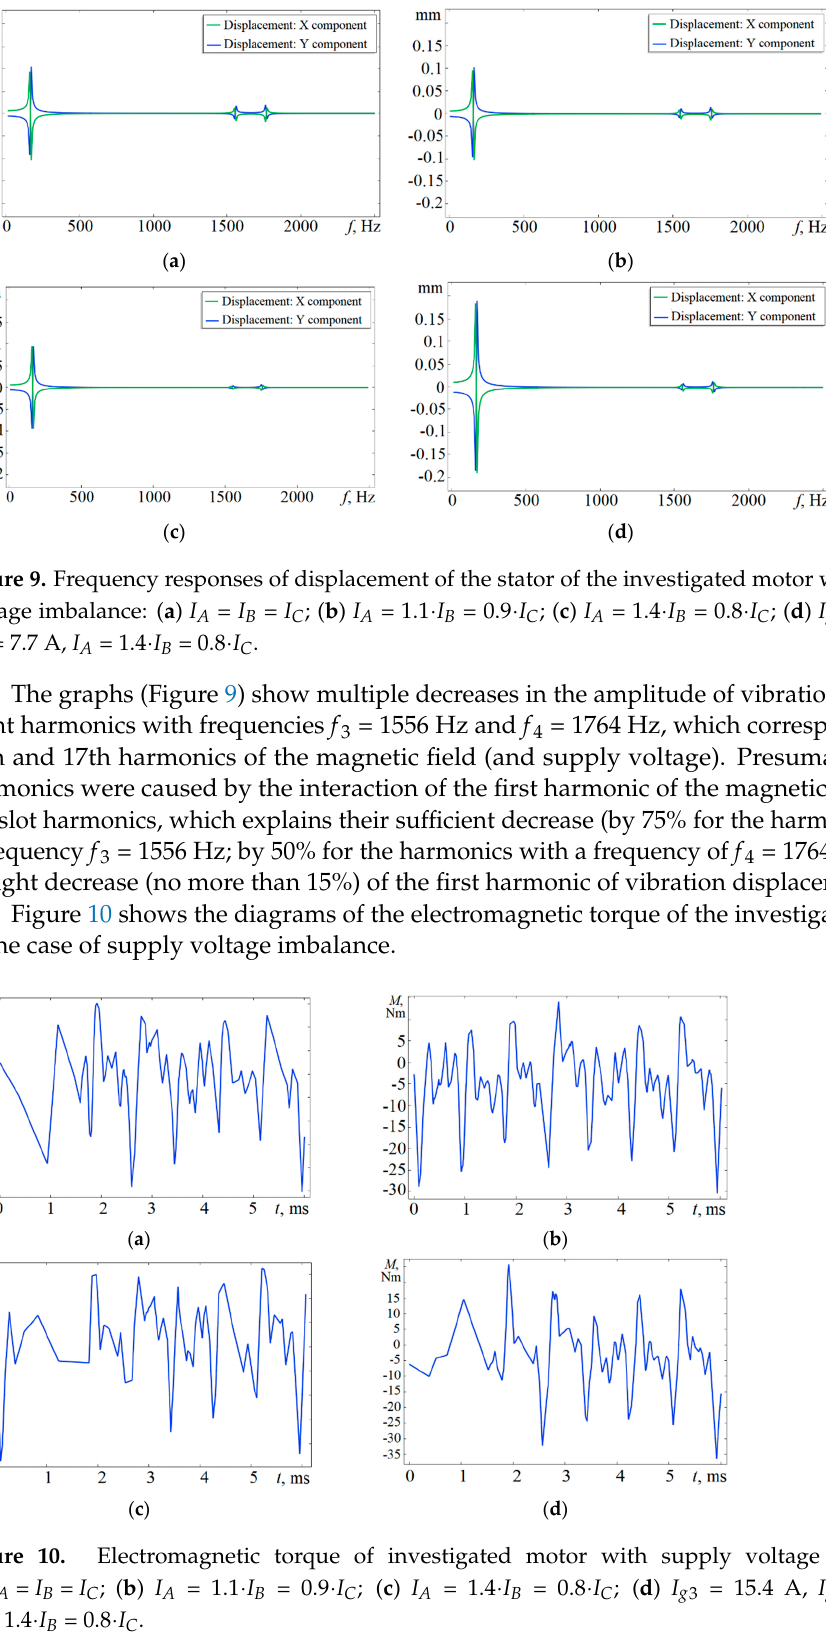
Figure 8. Acoustic radiation pressure of the investigated motor with supply voltage imbalance: ( a ) I A = I B = I C ; ( b ) I A = 1.1· I B = 0.9· I C ; ( c ) I A = 1.4 ·I B = 0.8 ·I C .